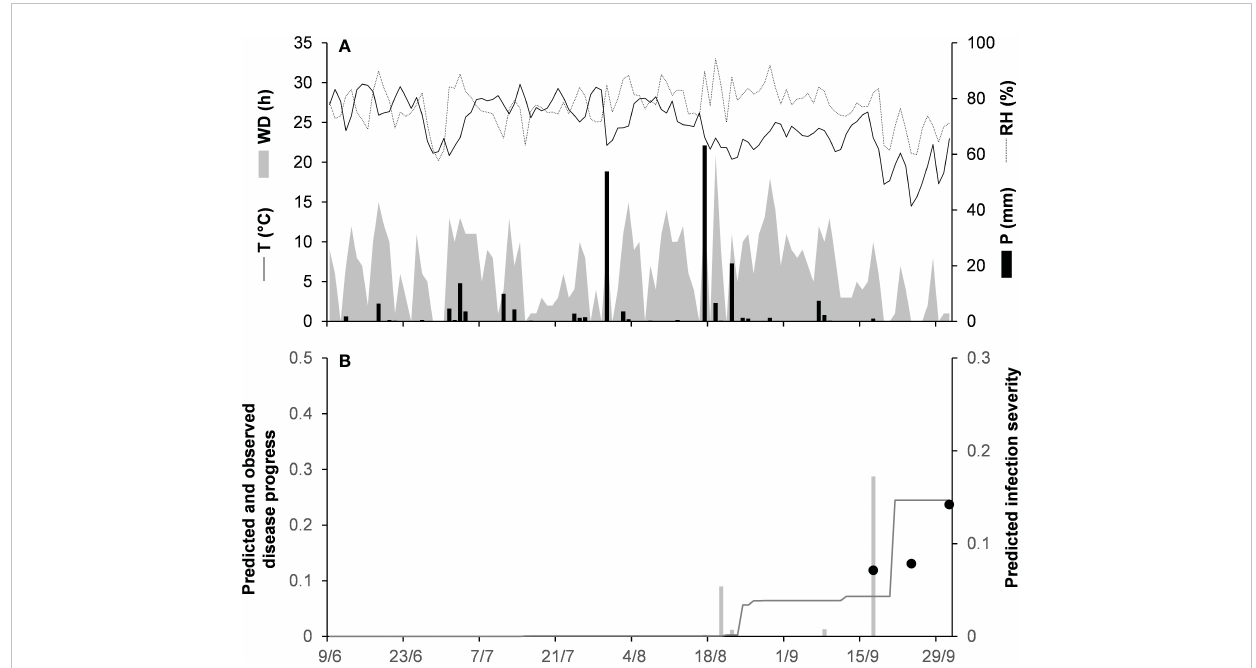
FIGURE 5 Predicted and observed disease progress on grape for the gloeosporioides clade in Castle Hayne, North Carolina, USA, in 1981 (NC-81). (A) Weather variables: air temperature (T, °C, solid line), relative humidity (RH, %, dotted line), rainfall (P, mm, black bars), and wetness duration (WD, in h, gray area). (B) Infection severity predicted by the model (light gray bars), disease severity predicted by the model (dark gray line), and observed disease incidence (full dots).